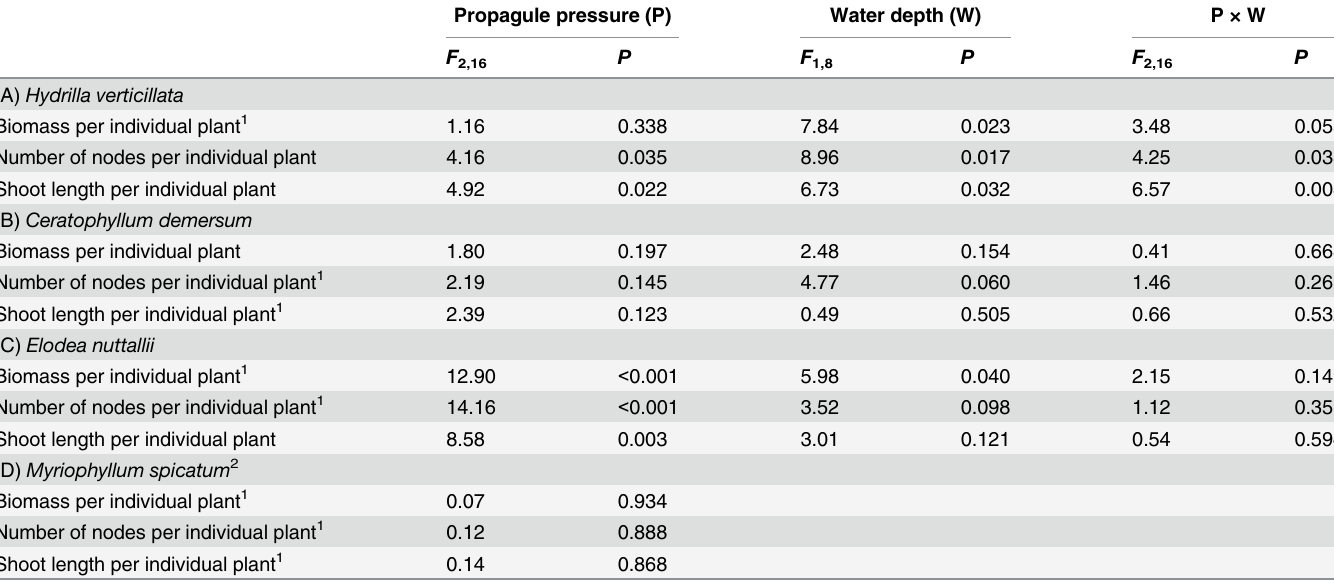
Table 3. Effects of propagule pressure and water depth on the growth per individual plant for each of the four submerged